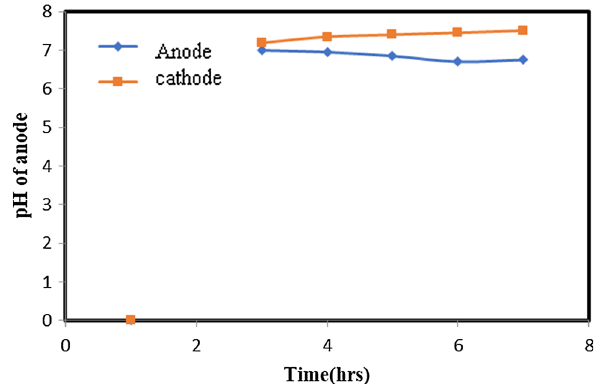
Fig. 7 pH Variation in anolyte and